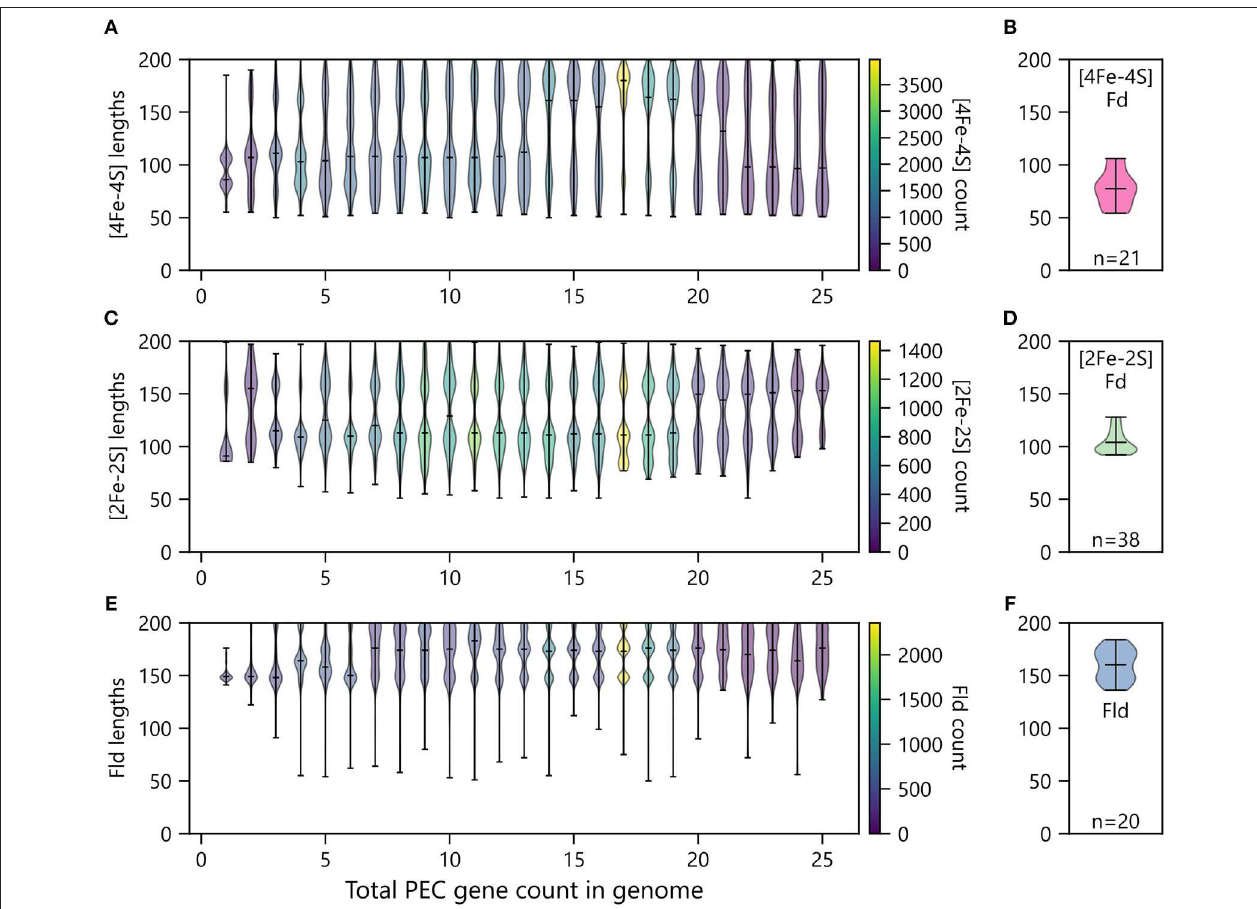
FIGURE 9 | Relationship between PEC length and number of PECs per organism. The abundances of (A) [4Fe-4S] Fds, (C) [2Fe-2S] Fds, and (E) Flds of different lengths encoded by genomes having different total numbers of PEC genes. Violin plots show the relative abundance of PECs having different sizes in each bin. The extrema are marked by horizontal edge lines at the ends of the vertical bars, and the average length is marked by an internal horizontal line. The number of genes within each violin plot is visualized using a viridis color gradient. For comparison, the lengths of (B) [4Fe-4S] Fd, (D) [2Fe-2S] Fd, and (F) Fld structures deposited in the Protein Data Bank (Berman, 2000). The number of structures used to generate these plots are noted at the bottom of each